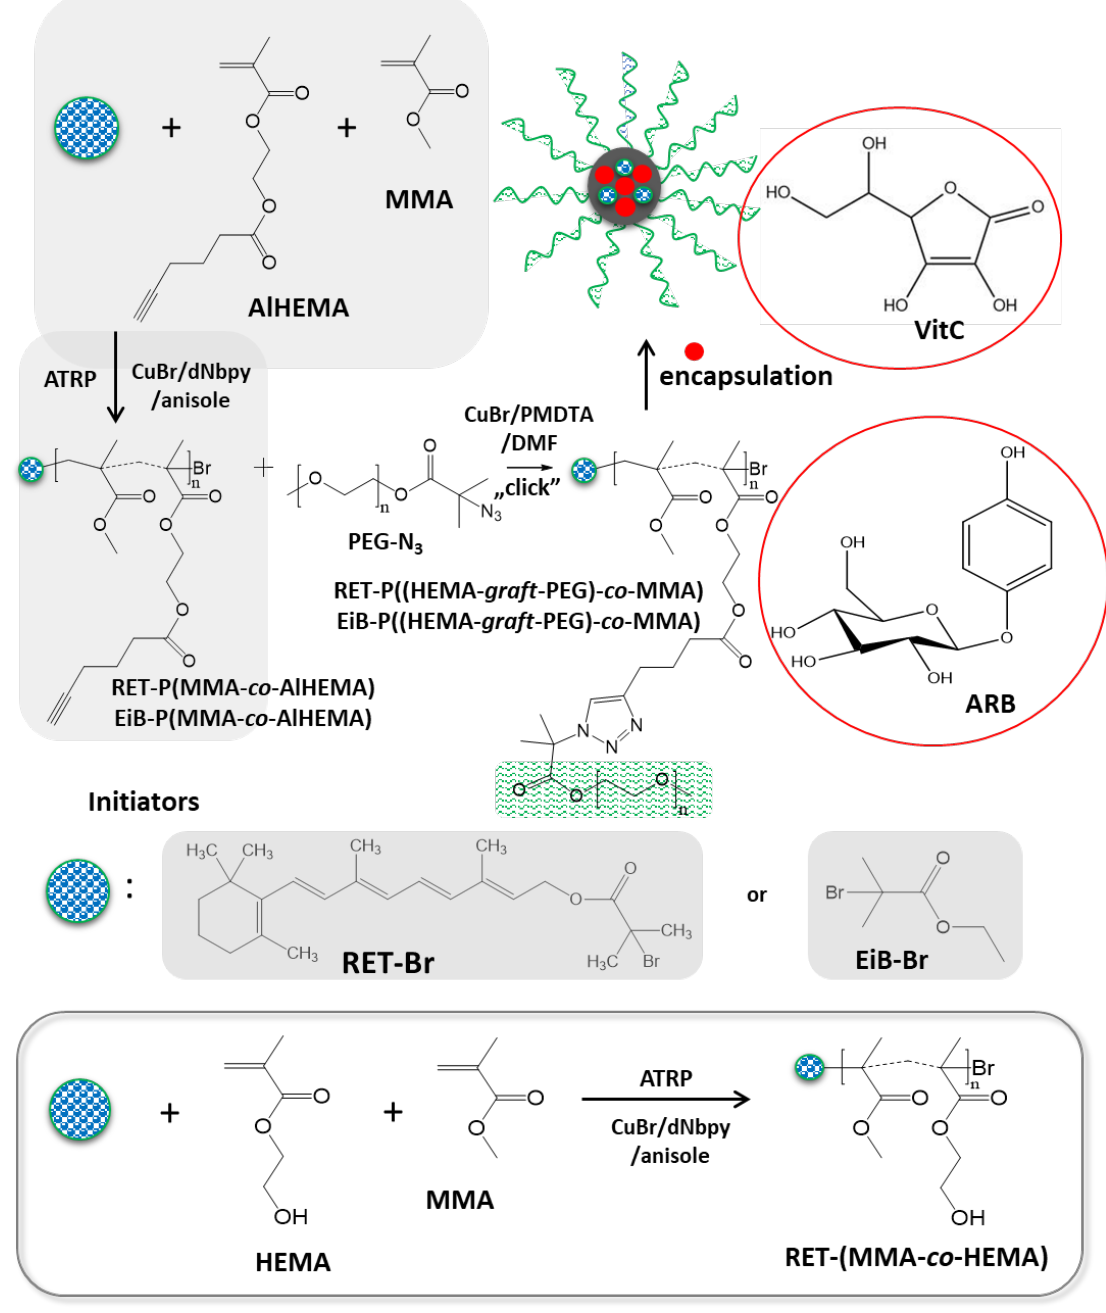
Figure 1. Synthesis of amphiphilic graft copolymers via grafting onto .